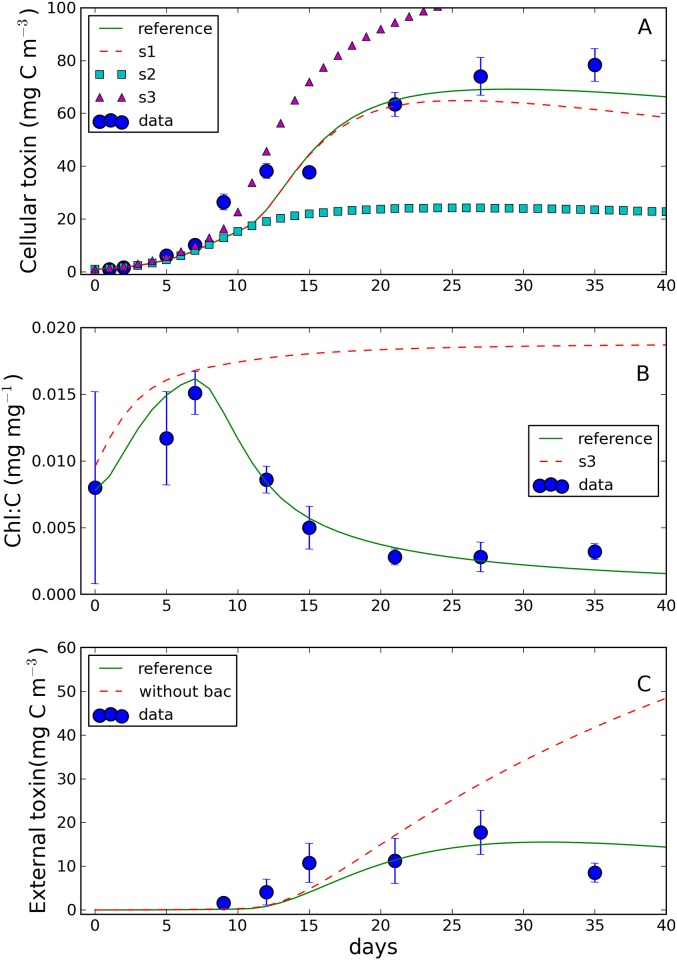
Sensitivity analysis with respect to selected model processes (experiment S1-3, see the text for explanation).(A) simulated and observed intracellular toxin; (B) modelled and observed chlorophyll to carbon ratio (Chl:C). (C) external toxin concentrations simulated with and without bacteria (bac). Data (with standard deviation) are also displayed.